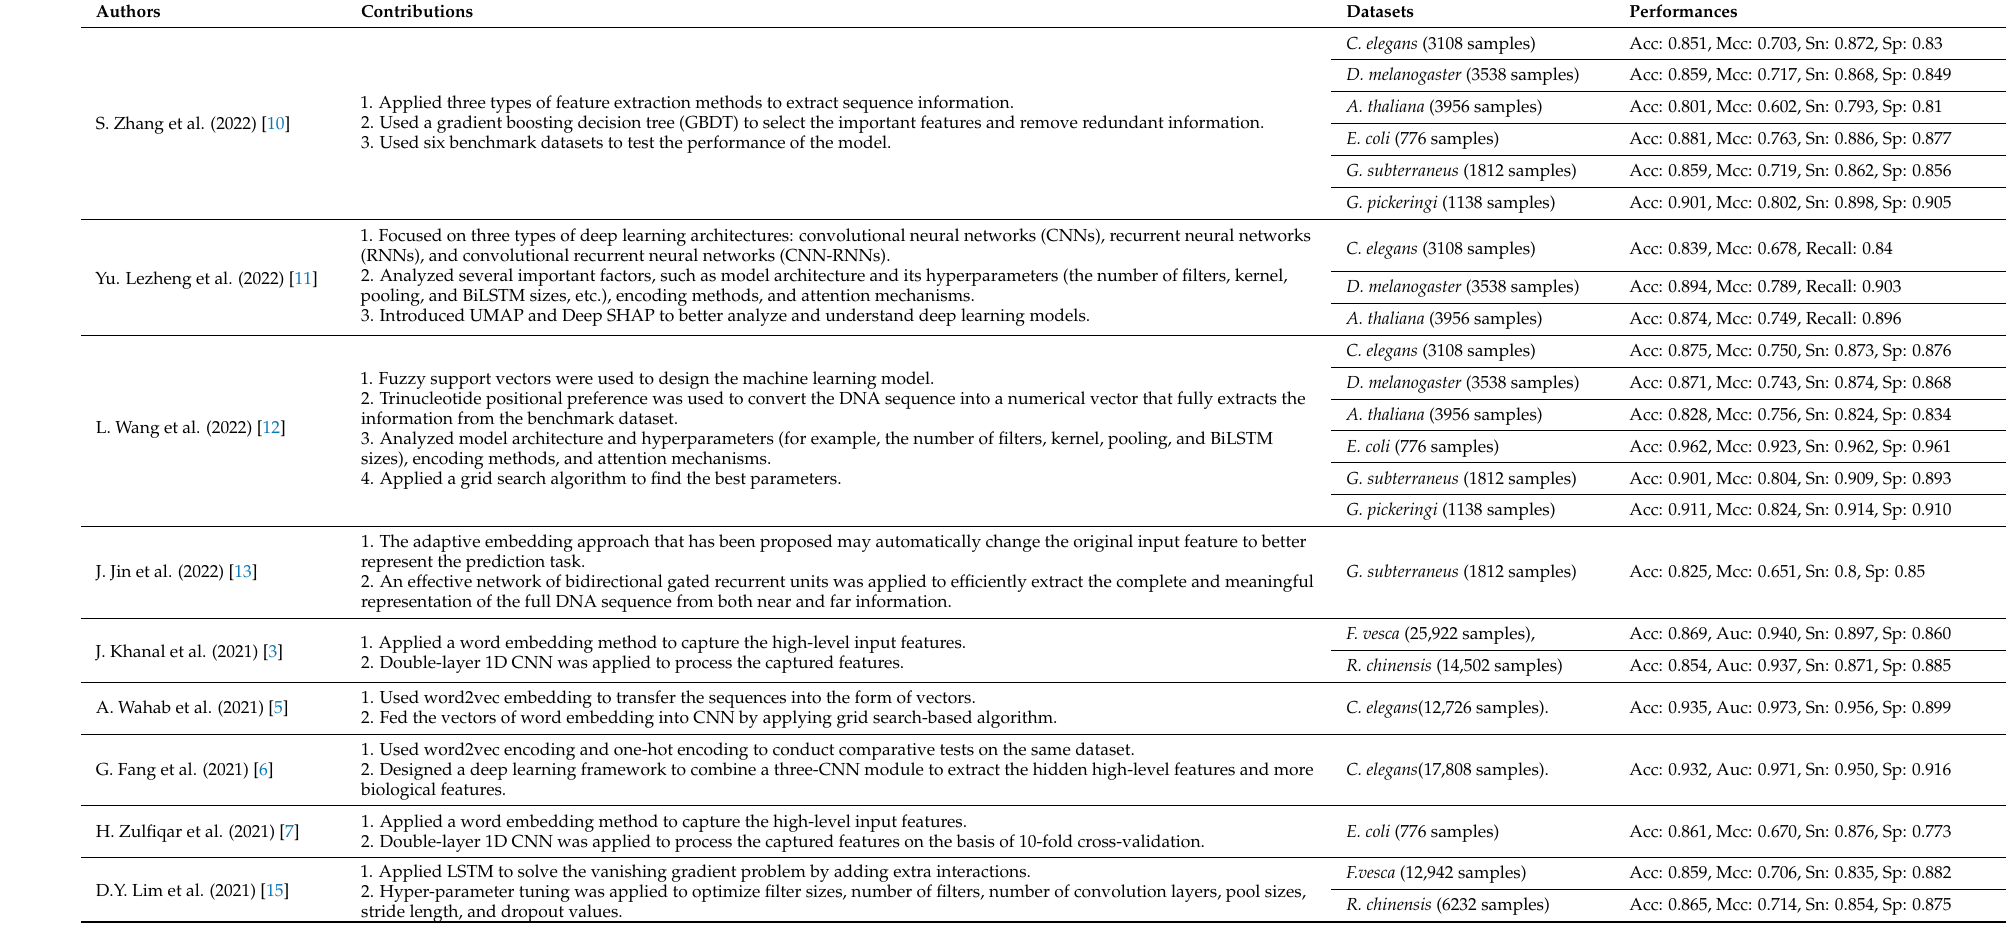
Table 1. Brief description of related studies adopted from the Refs.